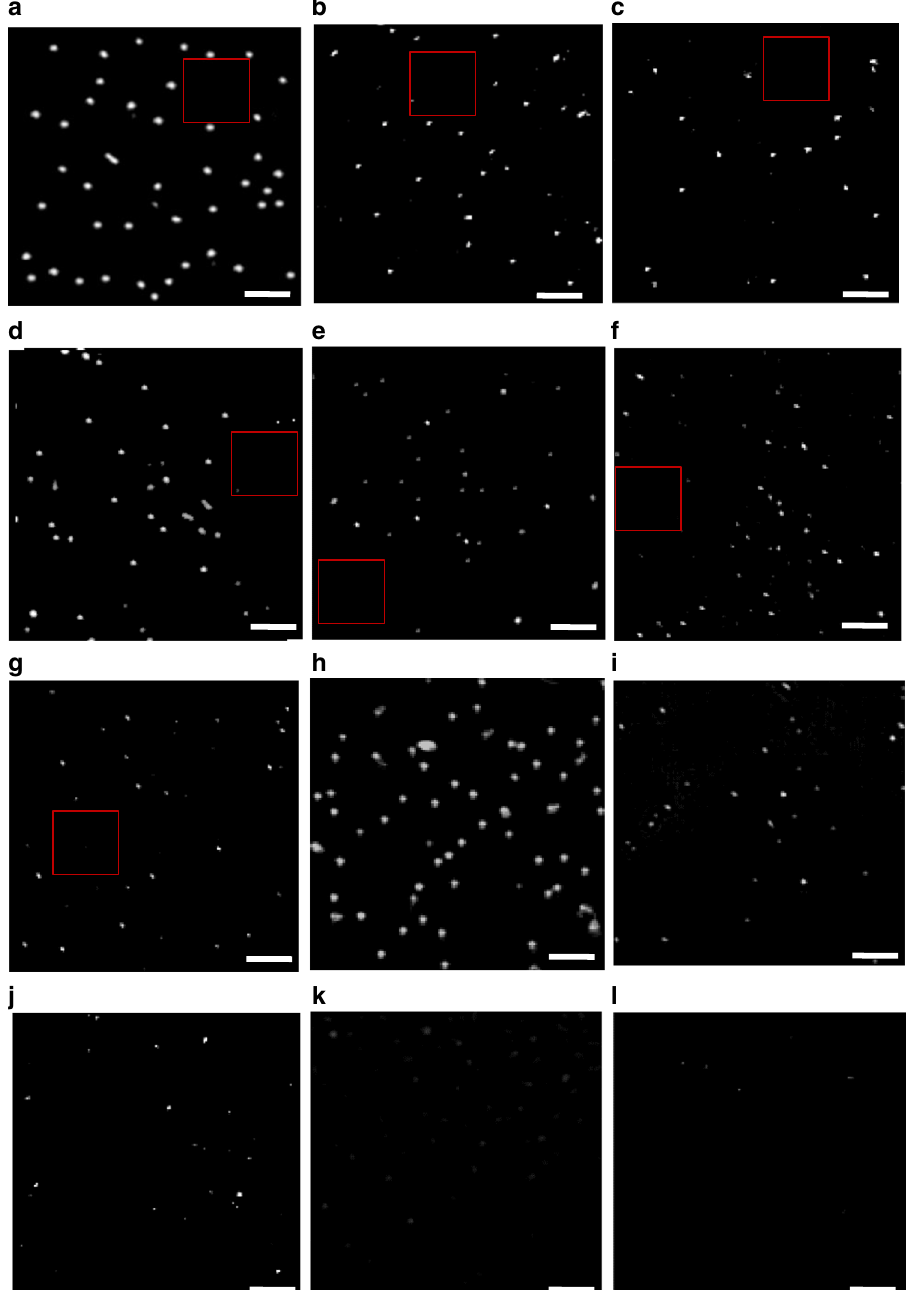
Fig. 1 Images of detected particles via PANORAMA and bright- fi eld. PANORAMA images of PS beads: a 750 nm, b 460 nm, c 300 nm, d 200 nm, e 100 nm, f 50 nm, and g 25 nm. Bright- fi eld images of PS beads: h 750 nm, i 460 nm, j 300 nm, k 200 nm, and l 100 nm. The squared regions are where the background IR was calculated in Fig. 2l. Scale bar: 5 µ